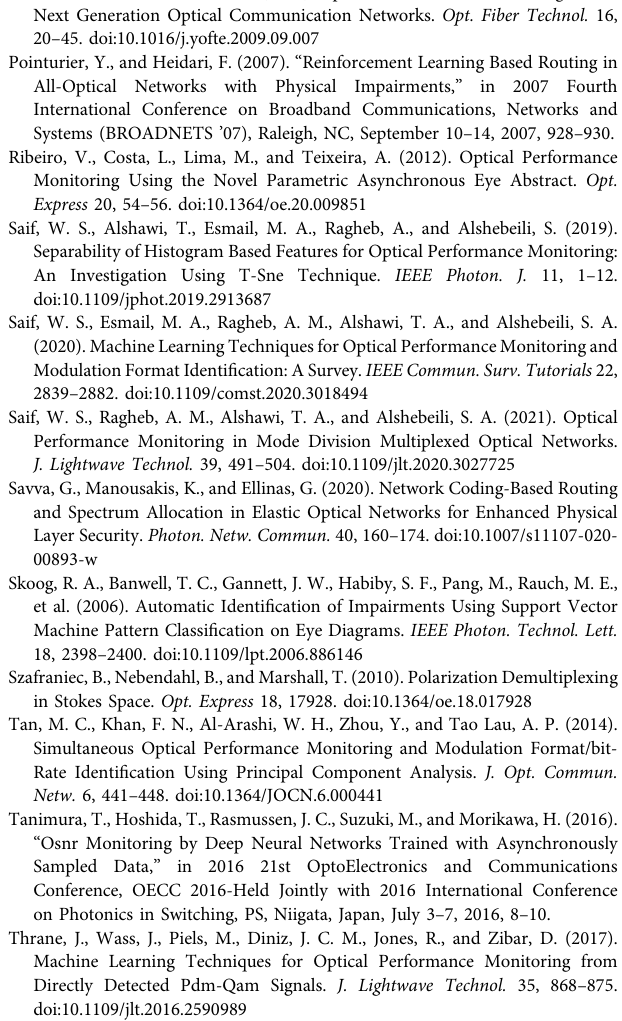
Algorithm for Coherent Optical Receivers. Opt. Express 25, 2038.